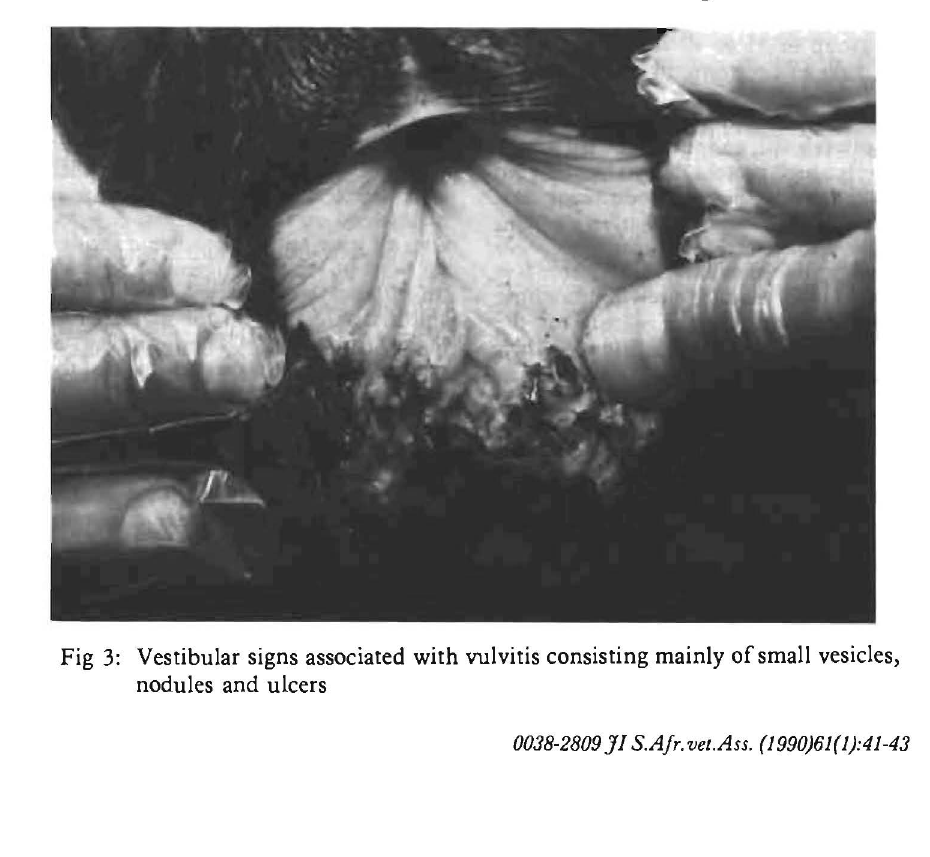
Fig 2: Later progression of vulvitis, showing severe ulcerative, granulomatous lesion developed more severe ocular lesions than unvaccinated control calves. Cor neal perforation was observed only in vaccinated calves, and frequency of isolation of Moraxella bovis was significantly greater in control calves.